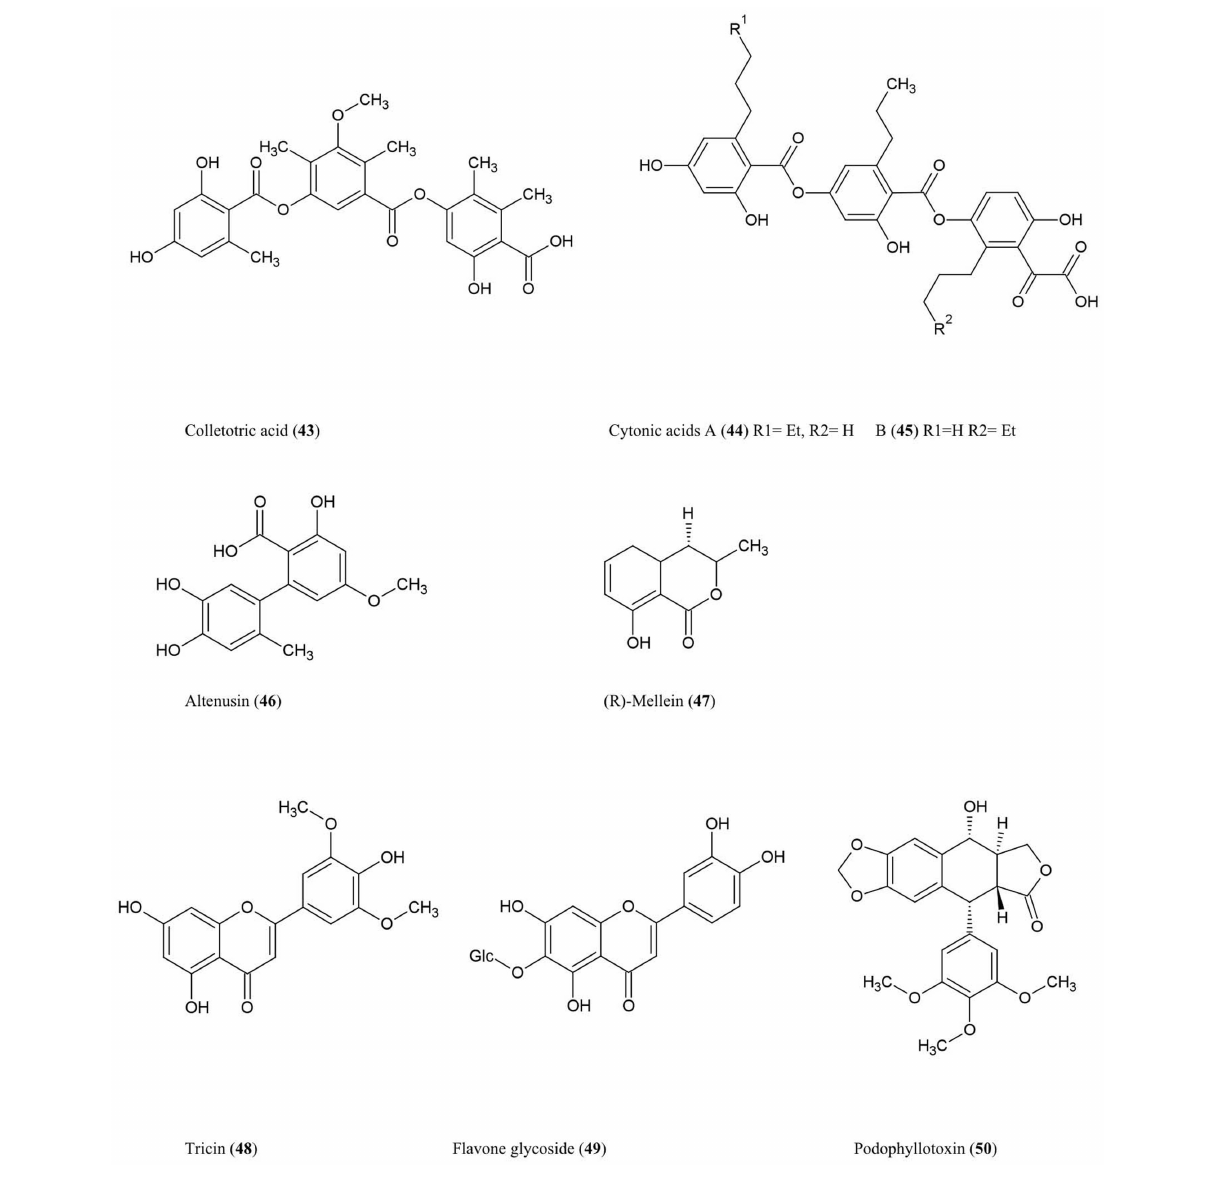
the opportunistic human pathogen cytomegalovirus by inhibiting a protease required for normal assembly of the viral nucleocapsid (Guo et al.,